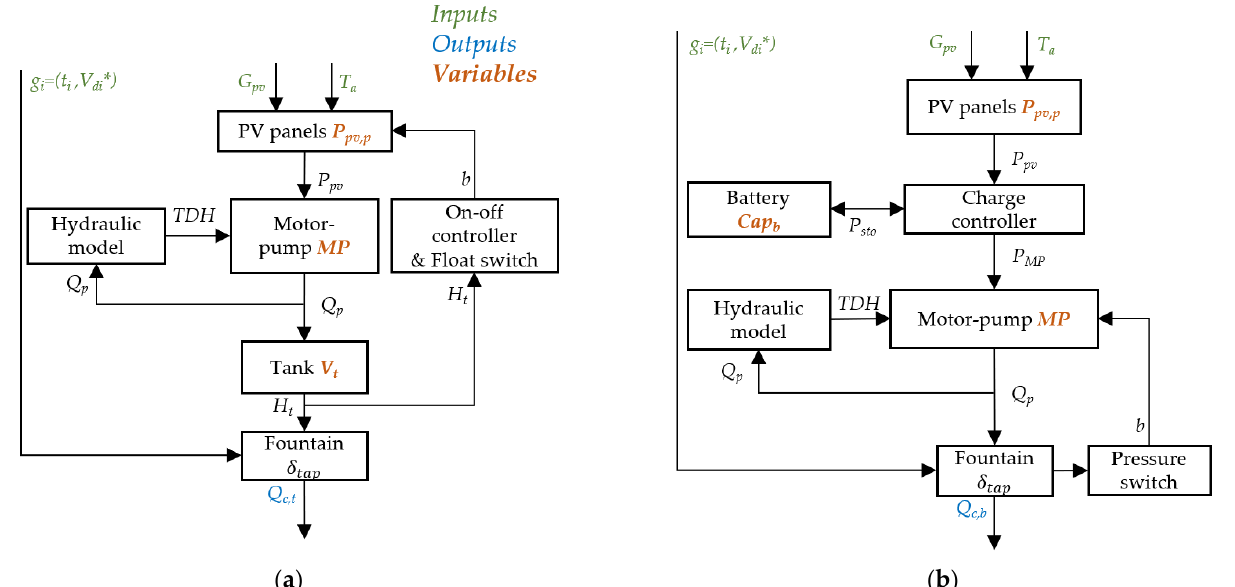
Figure 2. ( a ) Model of a PVWPS with tank storage. ( b ) Model of a PVWPS using battery storage.